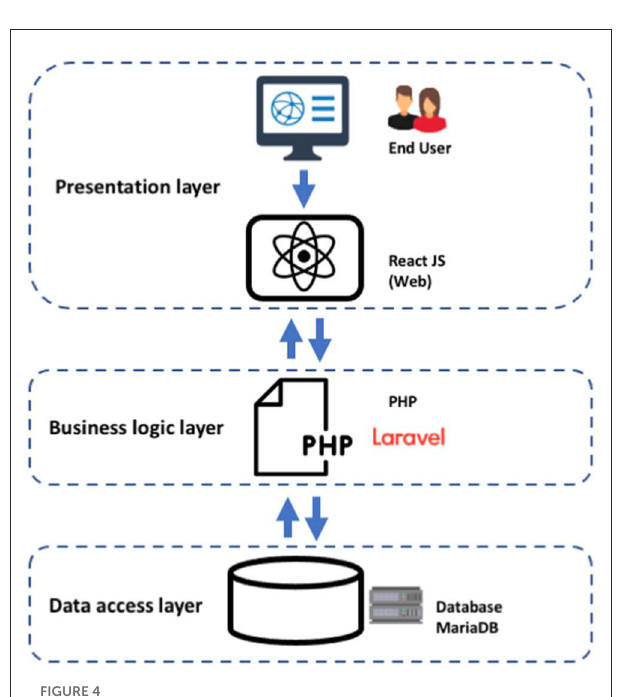
FIGURE4 Three-tier architecture implementation for the COVID-19Base v3